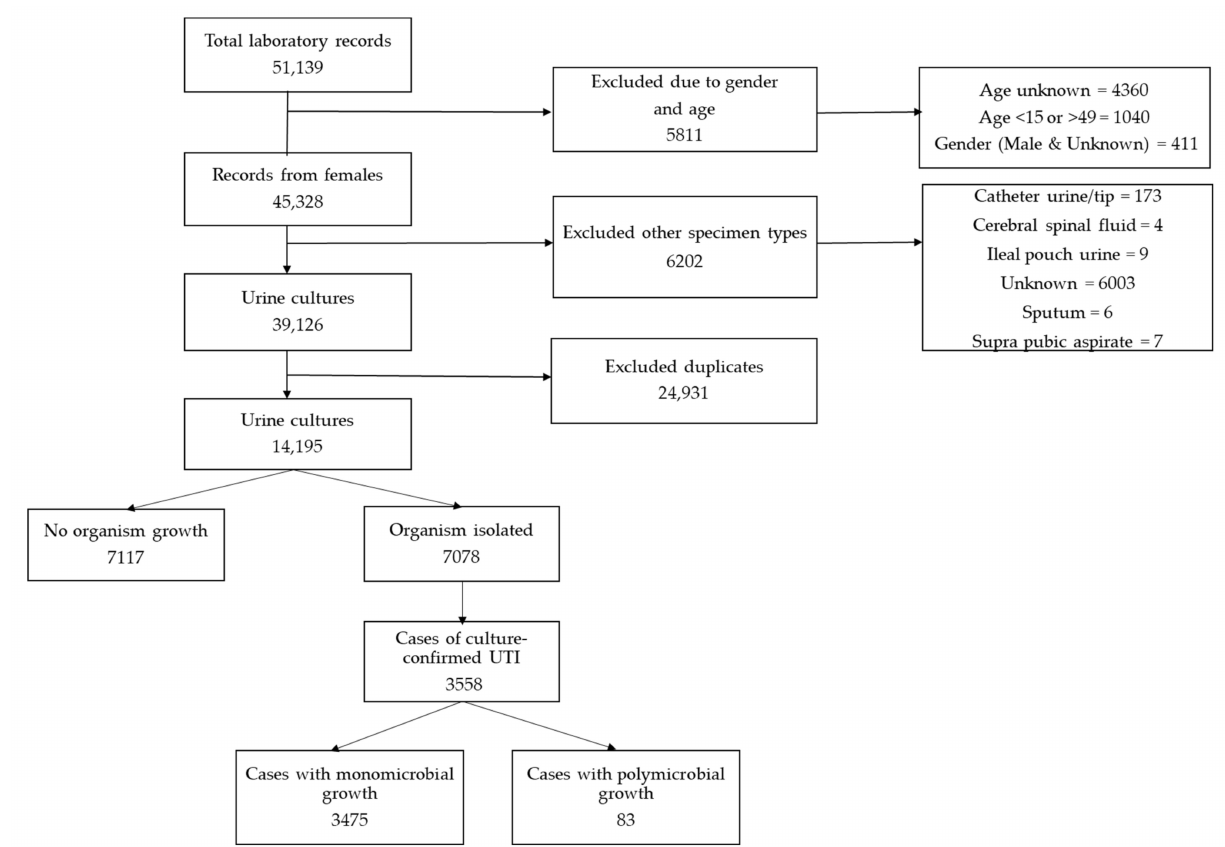
Figure 1. The number of culture-confirmed cases of urinary tract infections (UTIs) among women, with urine specimens collected while attending antenatal care at the four tertiary hospitals in Gauteng, 2015–2019.